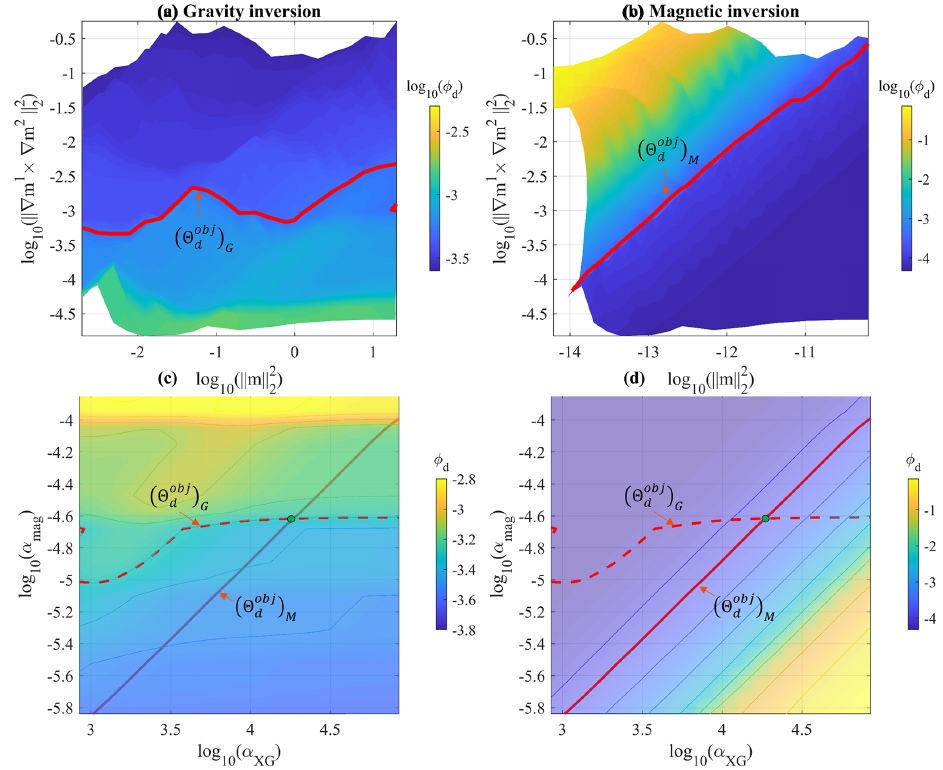
Figure 11. Determination of the optimum (α x ,α M ) parameters in the case of the joint inversion using the cross-gradient constraint. Top view of the elbow surfaces for gravity (a) and magnetic (b) inversions (top row) and a plot of the data misfit term as a function the α weights (bottom row). The solid lines show the contour values of the data misfit; values are given by the colour bar on the side. The solid red line shows the contour level of (cid:50) obj for the corresponding data set (gravity or magnetic), while the dashed line shows the same quantity for the d other data set. The green dot marks their intersection, indicating the optimum (α x ,α M ) values.